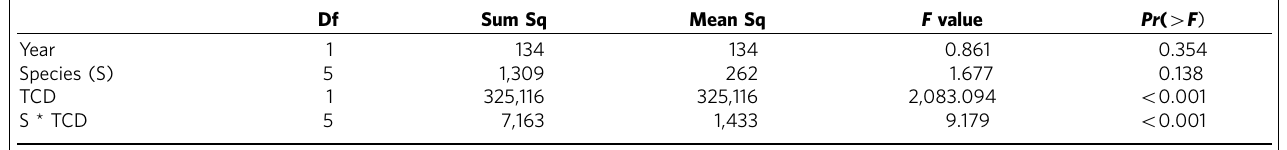
Table 1 | Temperature sensitivity of duration change for total aboveground activity period.